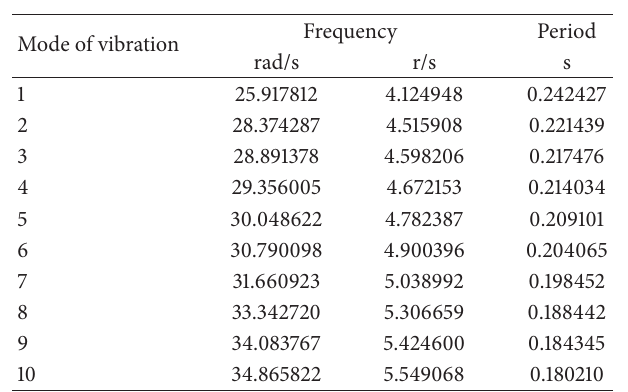
Table 3: Eigenvalue analysis results of slope.